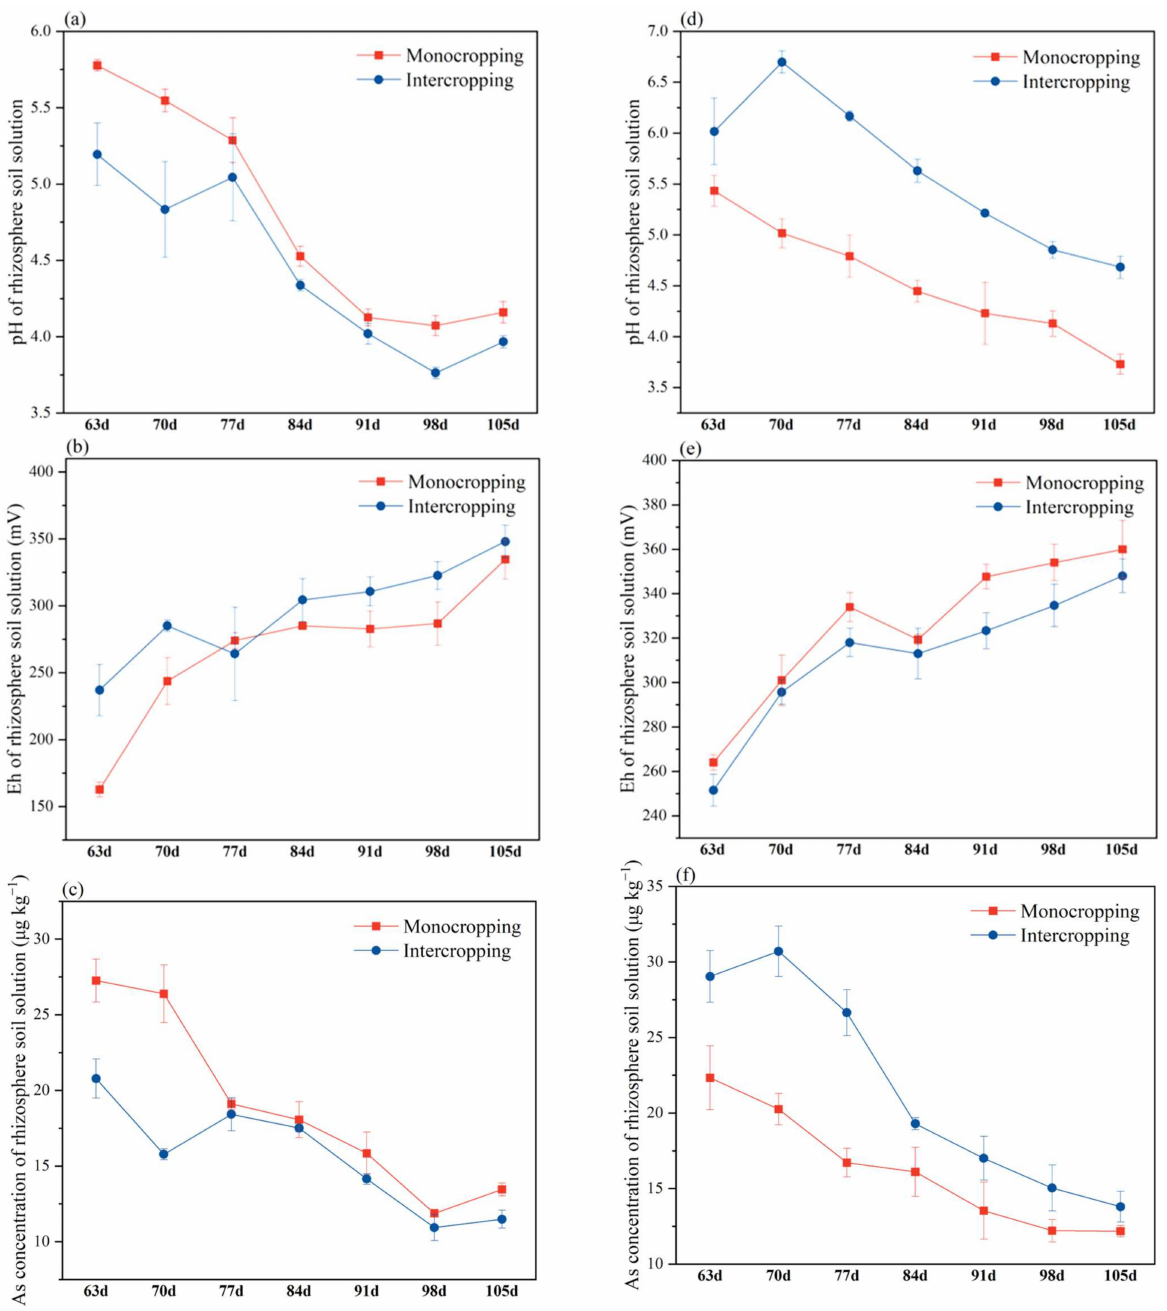
Figure 4. Changes in the pH, Eh, and As concentration in the rhizosphere soil solution of L. cylindrica ( a – c ) and S. cassiae ( d – f ) during the sampling period. Different lowercase letters indicate significant ( p < 0.05) differences between the treatments according to Duncan’s